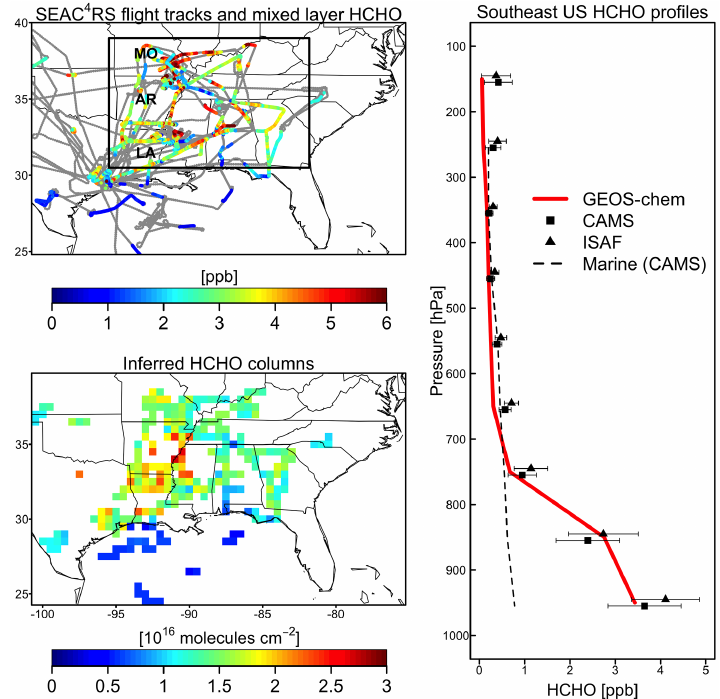
Figure 1. Formaldehyde (HCHO) concentrations along SEAC 4 RS aircraft flight tracks (5 August–25 September 2013). The top left panel shows the DC-8 flight tracks (in grey) and the CAMS measurements aboard the aircraft in the mixed layer. The mixed layer is the convectively unstable region of the atmosphere in contact with the surface, diagnosed locally from aerosol lidar observations aboard the aircraft (DIAL- HSRL Mixed Layer Heights README, 2014) and typically extending to 1–3km altitude. The states of Missouri (MO), Arkansas (AR) and Louisiana (LA) are indicated. The right panel shows the mean vertical profiles observed by the CAMS and ISAF instruments, and simulated by GEOS-Chem, for the southeast US domain (30.5–39 ◦ N, 95–81.5 ◦ W) defined by the black rectangle in the top left panel. Horizontal bars represent observed standard deviations. GEOS-Chem is sampled along the flight tracks at the time of the measurements. The dashed black line shows the mean vertical CAMS profile in marine air over the Gulf of Mexico (22–28 ◦ N, 96.5–88.5 ◦ W), which is used in determining background HCHO column (0.40 × 10 16 moleculescm − 2 ; see Sect. 3). The bottom left panel shows the mean HCHO columns on a 0.5 ◦ × 0.5 ◦ grid derived from the CAMS measurements after normalizing for temperature, for mixing depth and for the contribution from HCHO aloft (see text in Sect.